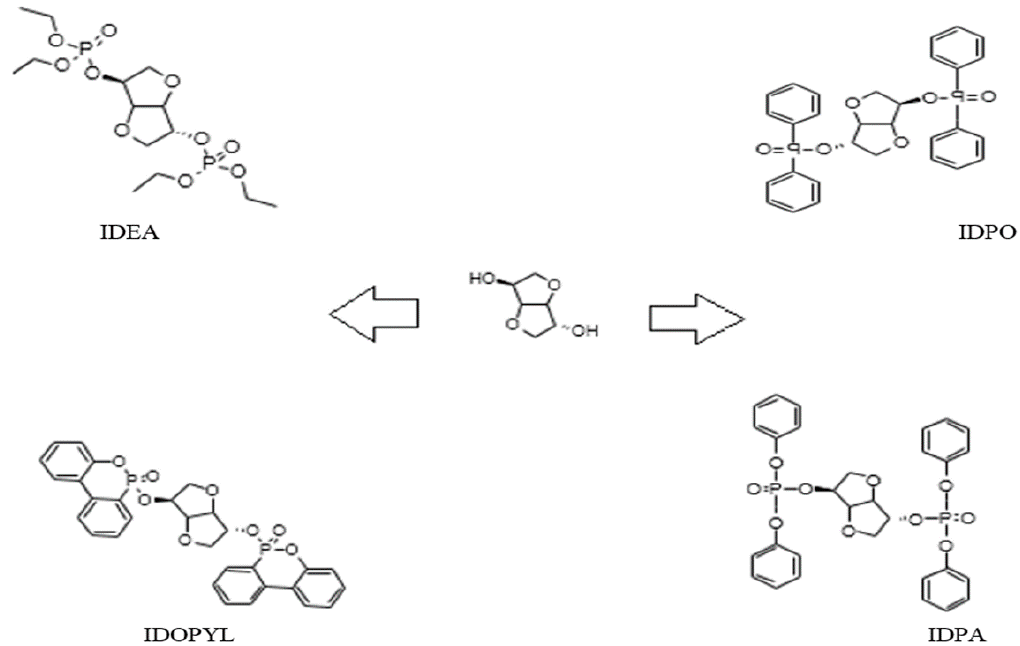
Figure 2. Phosphorus Esters of Isosorbide.